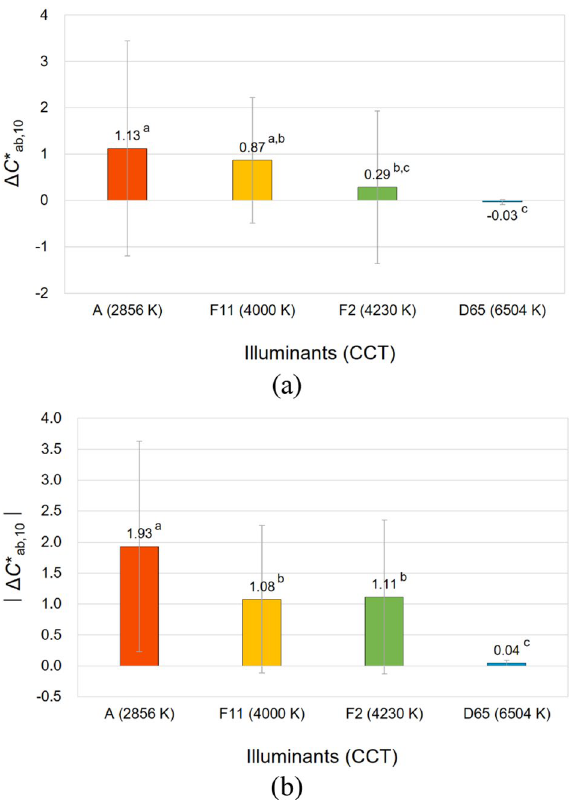
Figure 8. Effect of the correlated color temperature (CCT) of illuminants on the chroma appearance change, (cid:31) (cid:31) ( a ) Δ C * ab,10 and ( b ) (cid:31) (cid:31) C ∗ ab ,10 (cid:31) , of samples. (Δ C * ab,10 = C * A under the illuminant − spectrophotometrically measured C * ab,10 ).